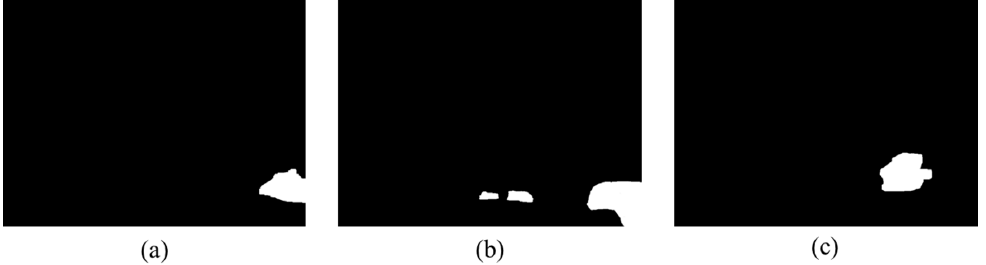
Figure 7. Extracted foreground region with example images. ( a ) Example image 1; ( b ) example image 2; ( c ) example image 3.